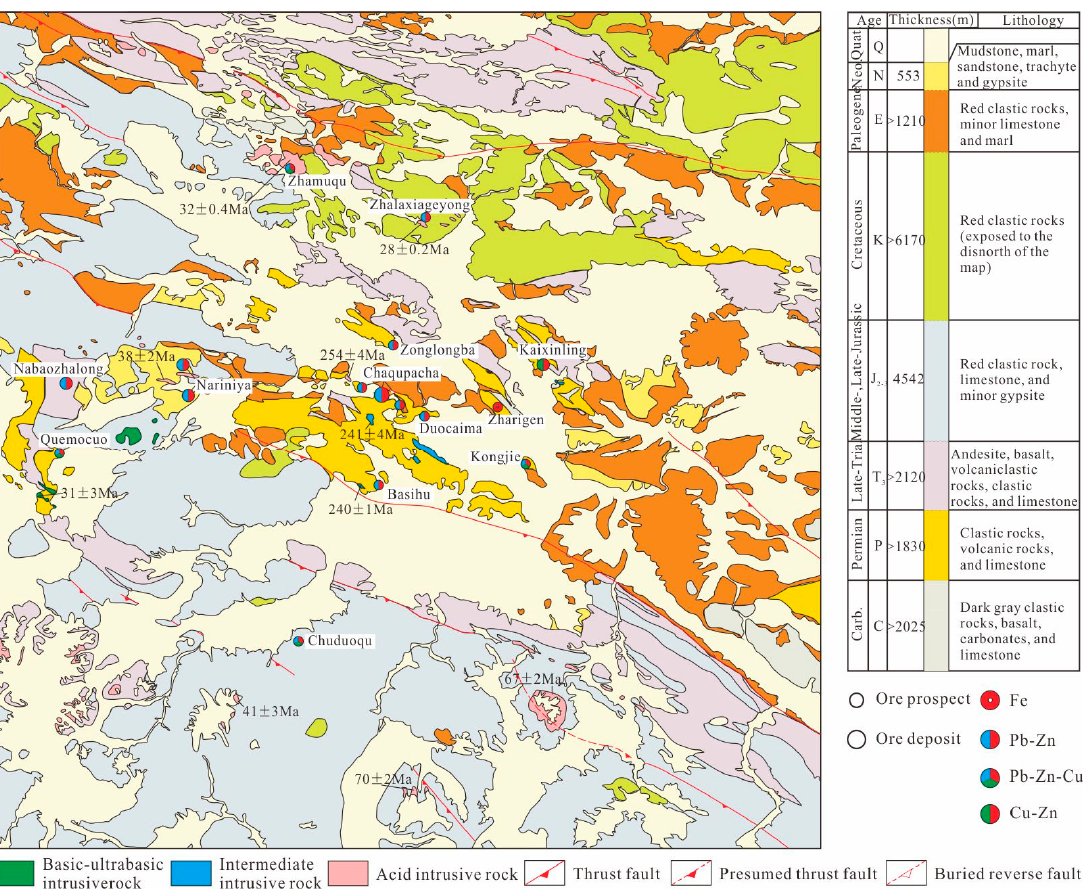
Figure 2. Simplified geological map of the Tuotuohe area, showing stratigraphy, thrust structure, and locations of the Chuduoqu ore deposit and other ore deposits; the map is simplified from six 1:250,000 scale geological maps, modified after [16].